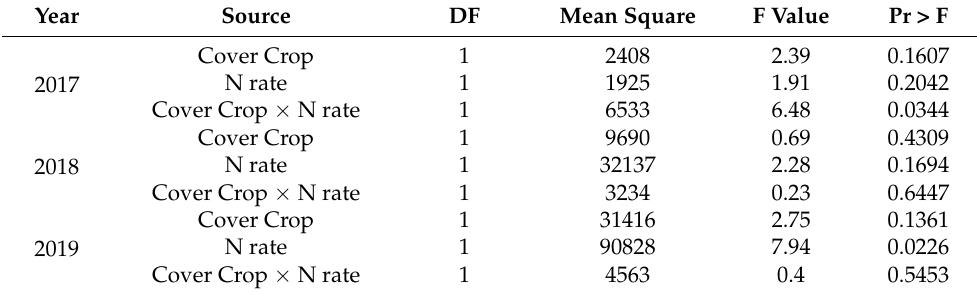
Table 1. ANOVA summary for lint yield response to cover crop and nitrogen application rates.